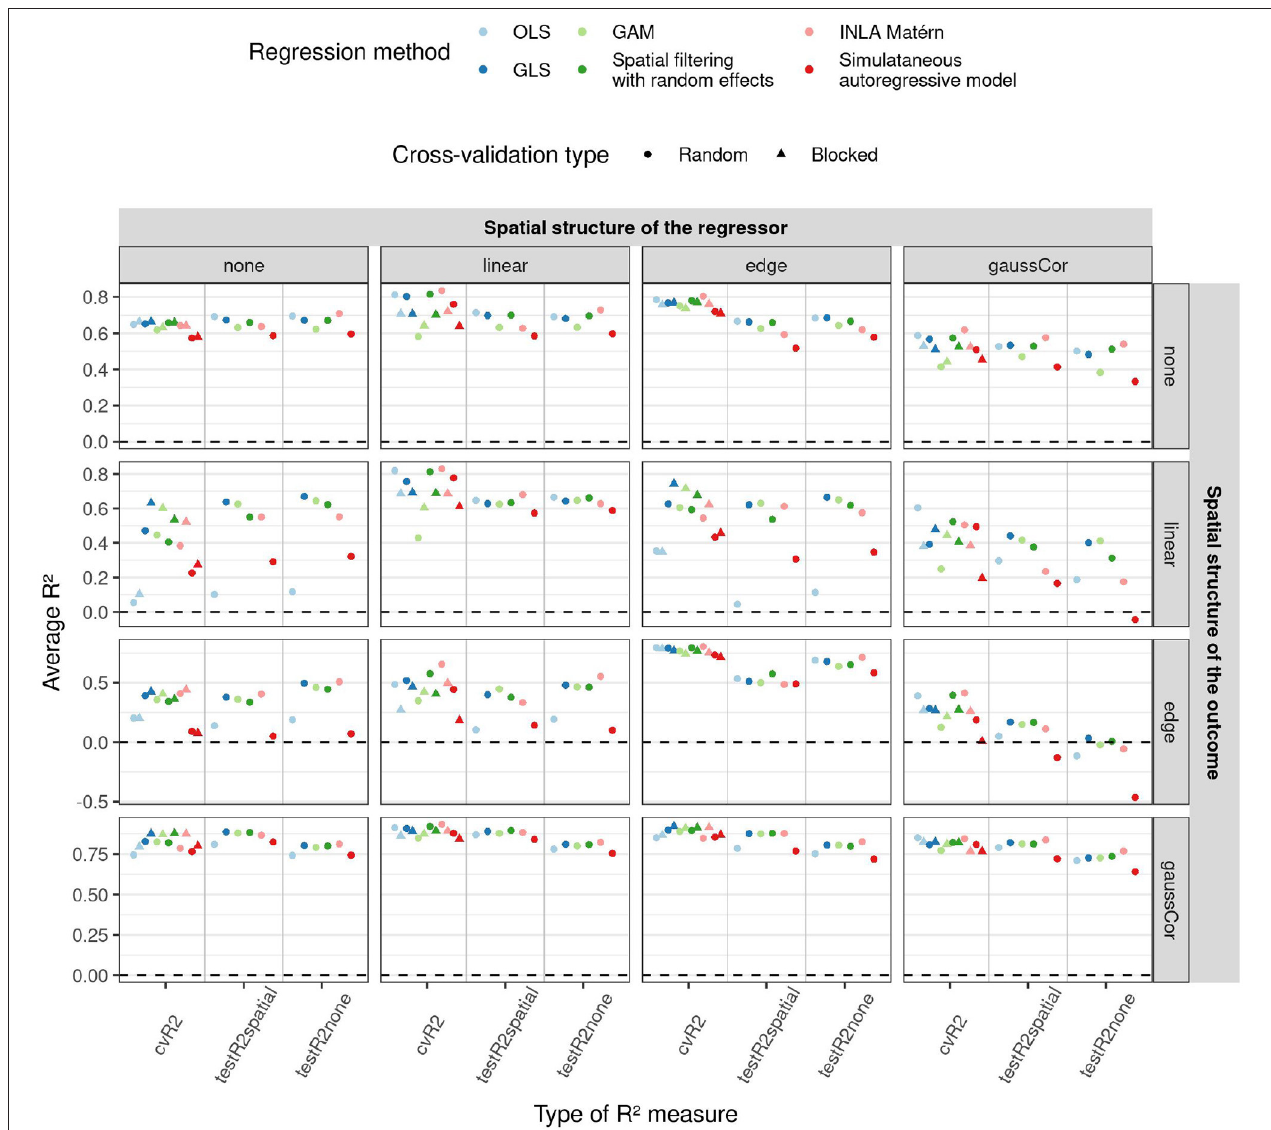
FIGURE 4 | Average R 2 (y-axis) for the low-dimensional scenario estimated by different cross-validation (CV) paradigms (shapes) and test datasets (x-axis) as a function of regression method (color) and of different correlation structures of the regressors (columns) and outcome (rows). In this low-dimensional scenario, the model fit and hence also test R 2 values do not depend on the CV paradigm, so results are only shown for random CV for the test R 2 . 1,000 Monte Carlo runs were executed, the standard deviation of the non-zero components of β were 1. Supplementary Figures S20, S21 show similar figures for standard deviations 0.5 and